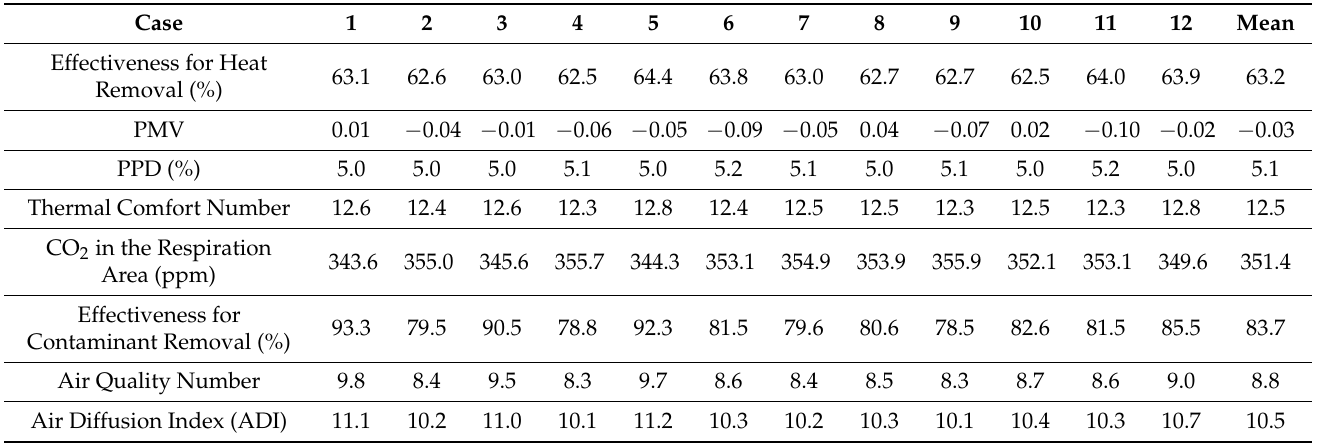
Table 11. ADI obtained for Case IV (0.1944 m 3 /s) at 10